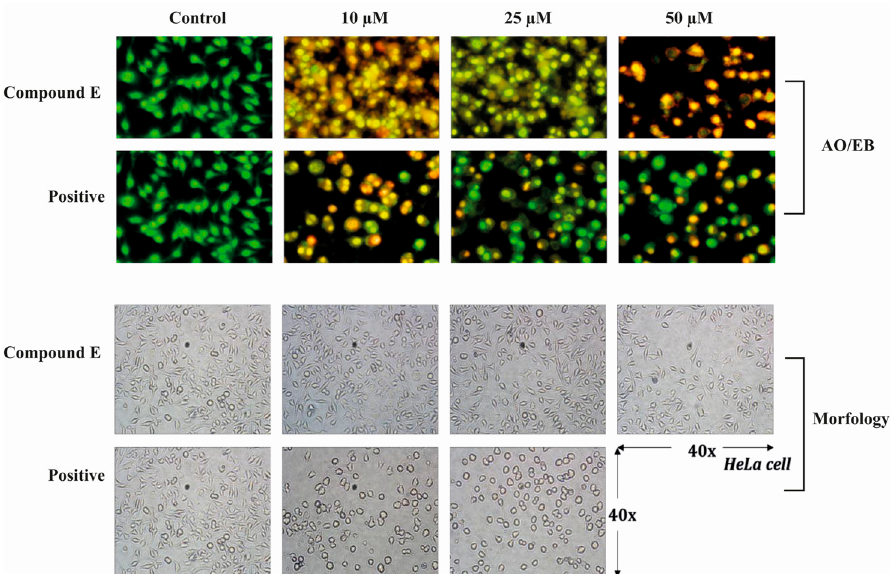
Figure 2. Acridine orange/Ethidium bromide staining of HeLa cells. Compound E triggered apoptosis in HeLa cells, which is marked with bright red and yellow, compared to the green-stained control HeLa cells in which compound E was not administrated. Images were obtained under florescence microscope.